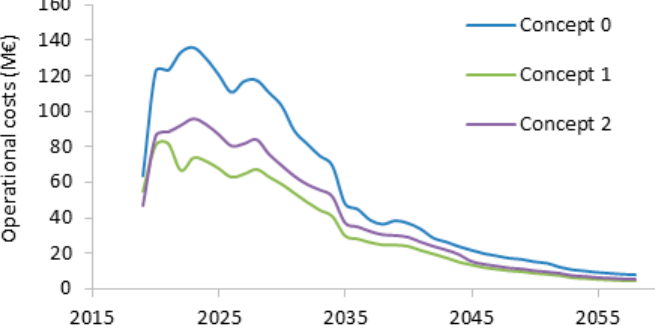
Figure 14. Total operational costs for the different concepts selected (NP scenario).